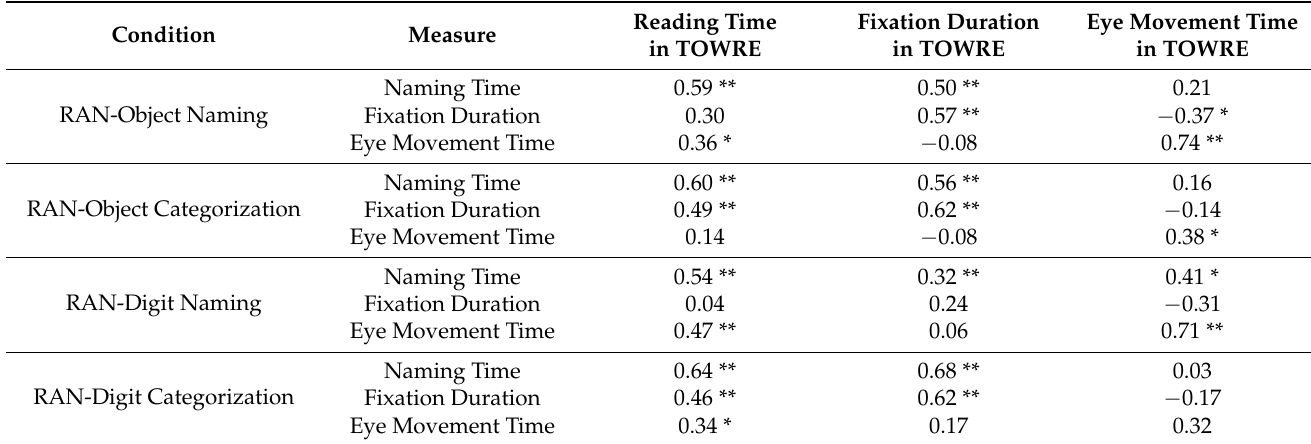
Table 7. Pearson’s correlation between naming times and eye movement variables in RAN-related tasks and naming times and eye movement variables in word reading task (TOWRE).